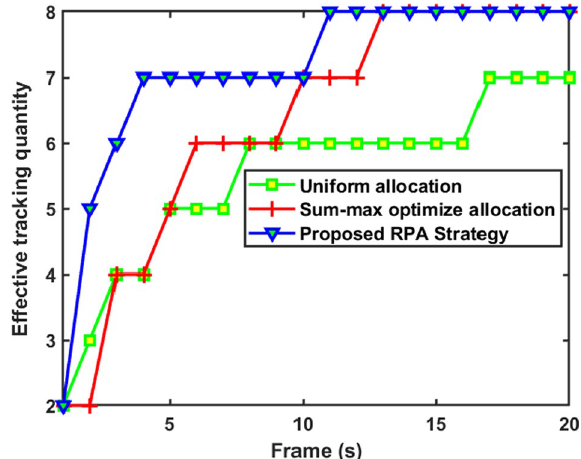
Fig. 3 Performance comparison in terms of the effective tracking quantity in scenario